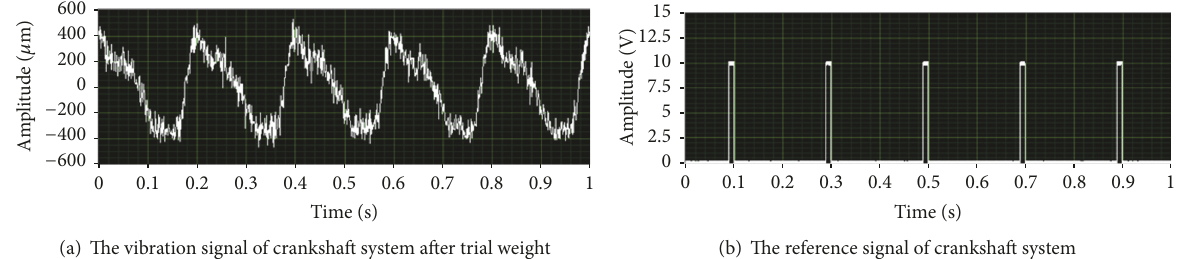
Figure 9: The vibration signal and reference signal of crankshaft system after trial weight.